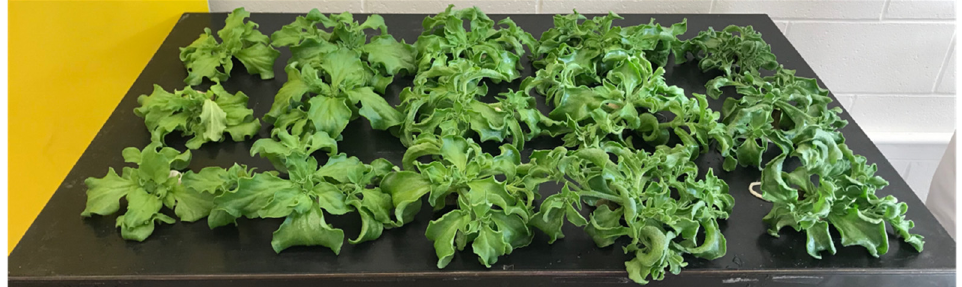
Figure 5. Images of ice plants harvested after 21 days of light treatment. Columns from left to right show 8, 12, 16, 20, and 24 h treatments.